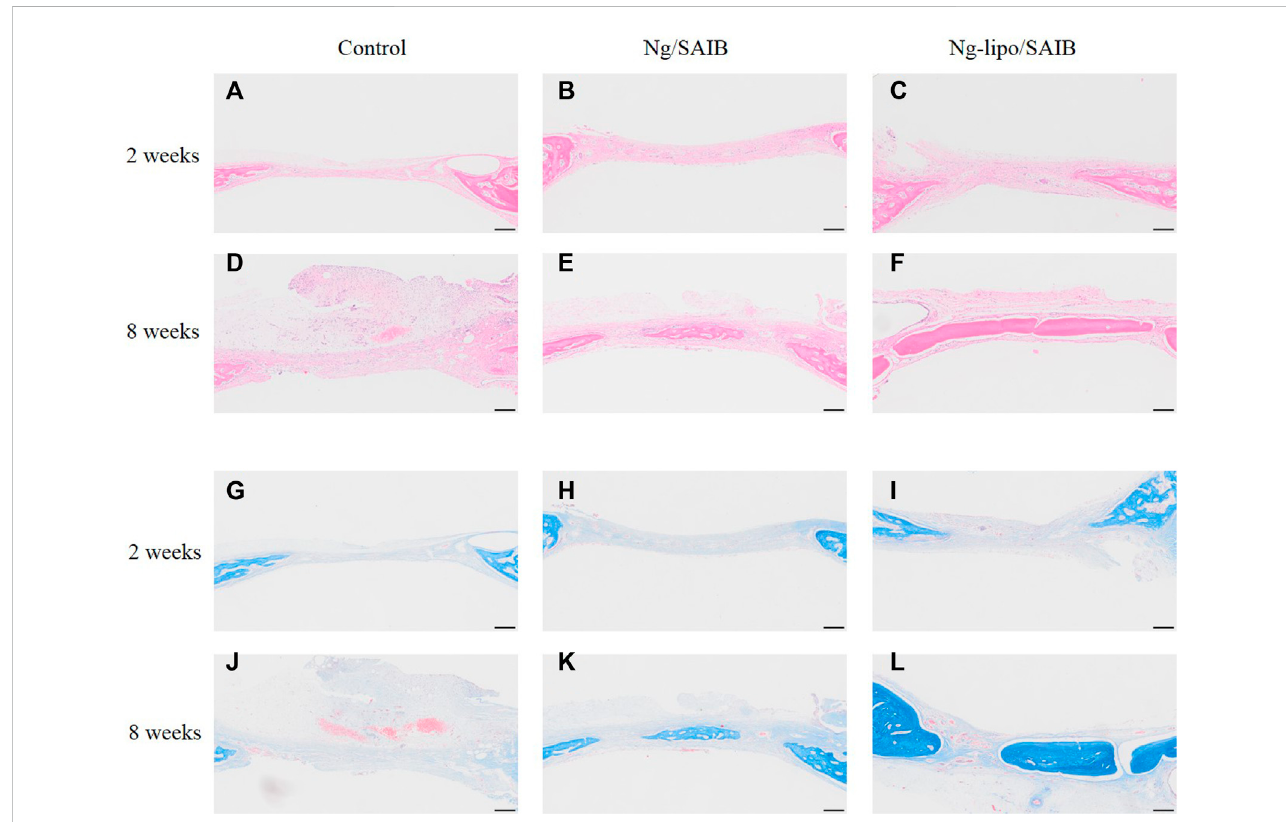
FIGURE 7 Representative HE (A – F) and Masson (G – L) staining of the bone regeneration region. Images of different groups at 2- and 8-weeks post-surgery are shown. Scale bar = 200 μ m.